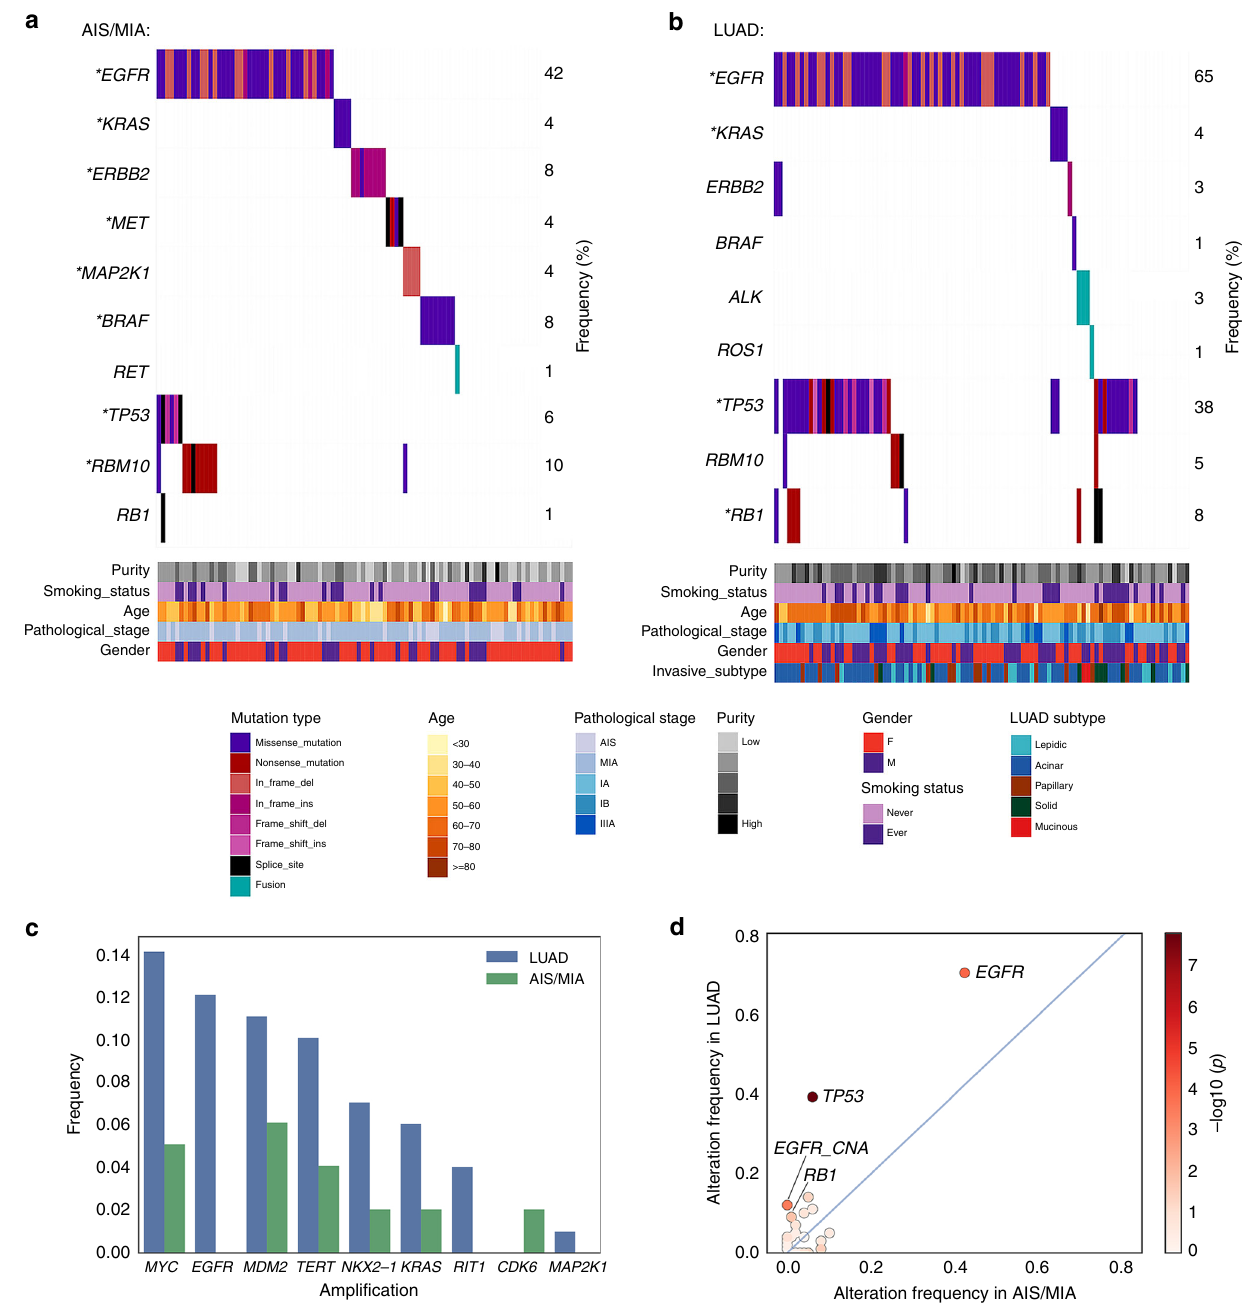
Fig. 1 Somatic alterations in pre-invasive and invasive lung adenocarcinomas. a Co-mutation plots for AIS/MIA and b LUAD. Stars indicate signi fi cantly mutated genes in each group. c Lung cancer genes with focal ampli fi cation in AIS/MIA and LUAD. d Somatic alterations with higher frequencies in LUAD, compared to AIS and MIA. Color bar represents log 10 -transformed p value calculated from two-sided Fisher ’ s exact test. Source data are provided as a source data fi precursor form of squamous cell carcinoma 18 . We have shown microenvironment. Our work provides new insights into the the high frequency of oncogenic driver mutations, but low fre- biology of lung pre-malignancy, with implications for disease quency of TP53 mutations in the LUAD precursors. Previous monitoring and prognosis, and future therapeutic intervention. studies have suggested the functional association of TP53 muta- tions with invasive potential in cancers 19 . Our fi ndings also demonstrate a strong association of TP53 mutations with aneu- ploidy, in line with recent work from TGCA 20 . Given previous reports of aneuploidy in association with decreased immune in fi ltration 20,21 , our data raise the possibility that copy-number changes in speci fi c chromosomes may in fl uence the tumor